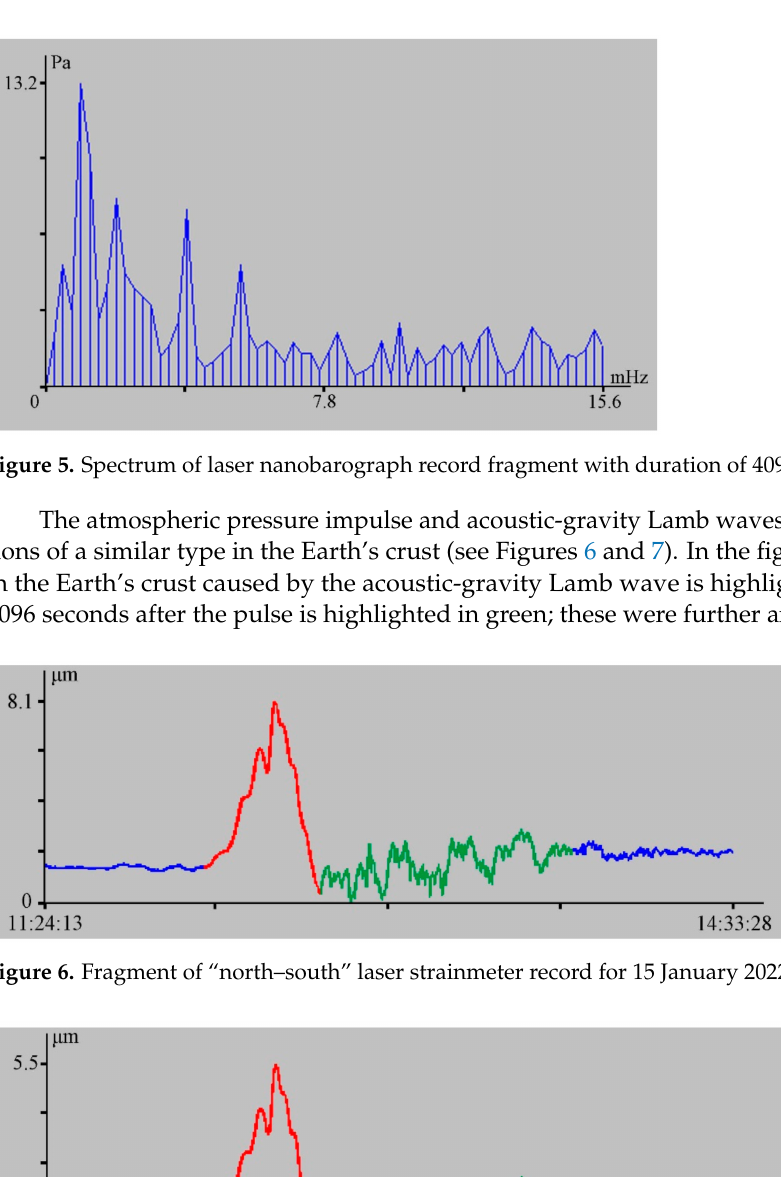
Figure 4. Fragment of laser nanobarograph record for 15 January 2022, UTC.